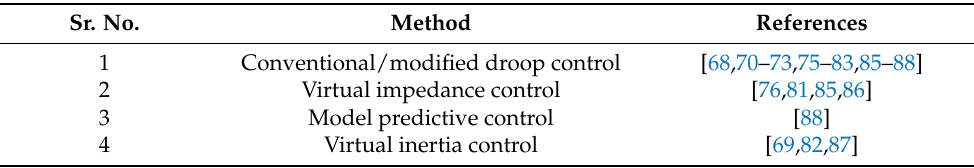
Table 2. Majorly discussed control techniques in power-sharing